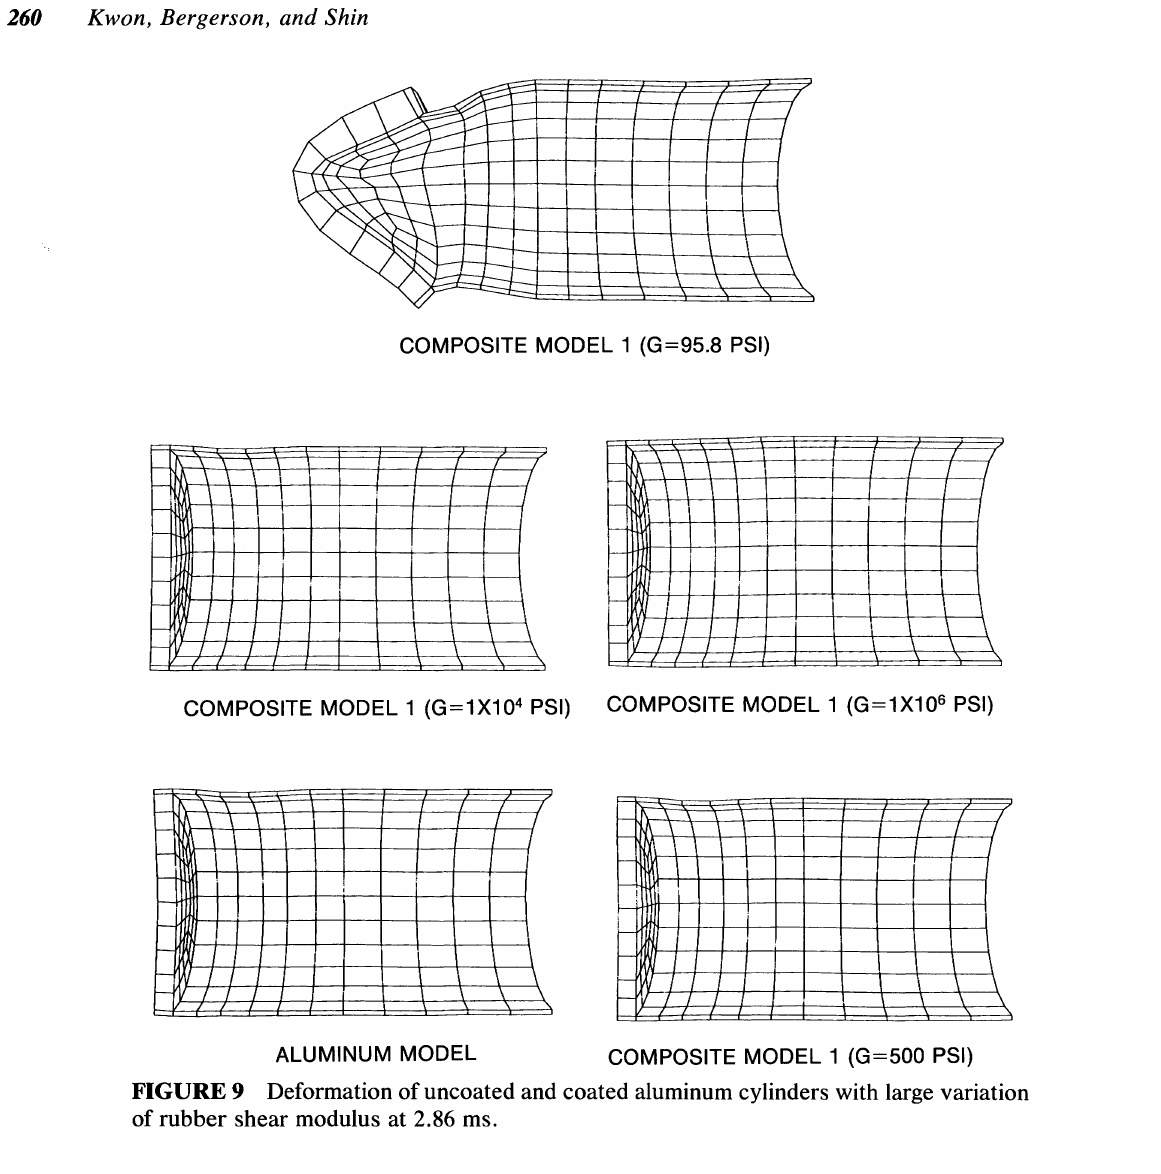
FIGURE 9 Deformation of uncoated and coated aluminum cylinders with large variation of rubber shear modulus at 2.86